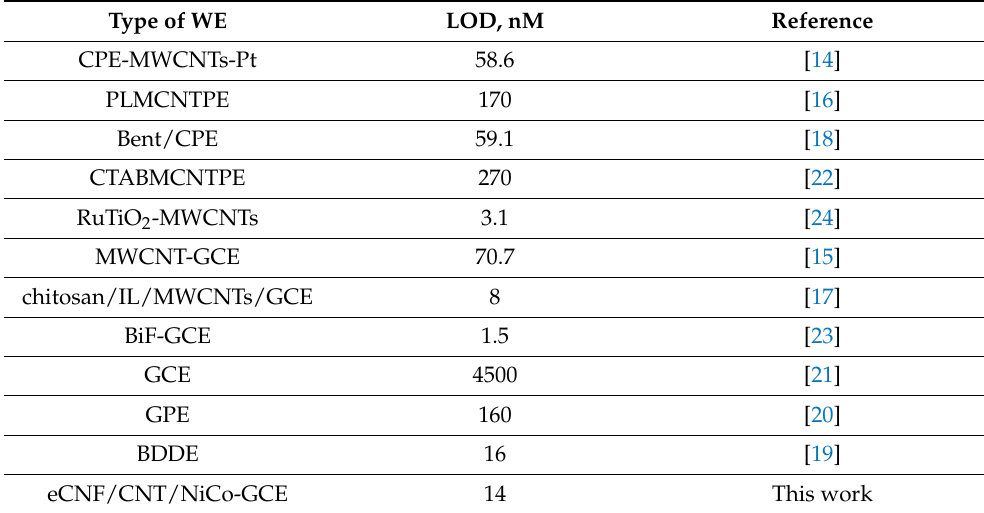
Table 1. Comparison of LOD values for CTZ obtained using voltammetric methods.